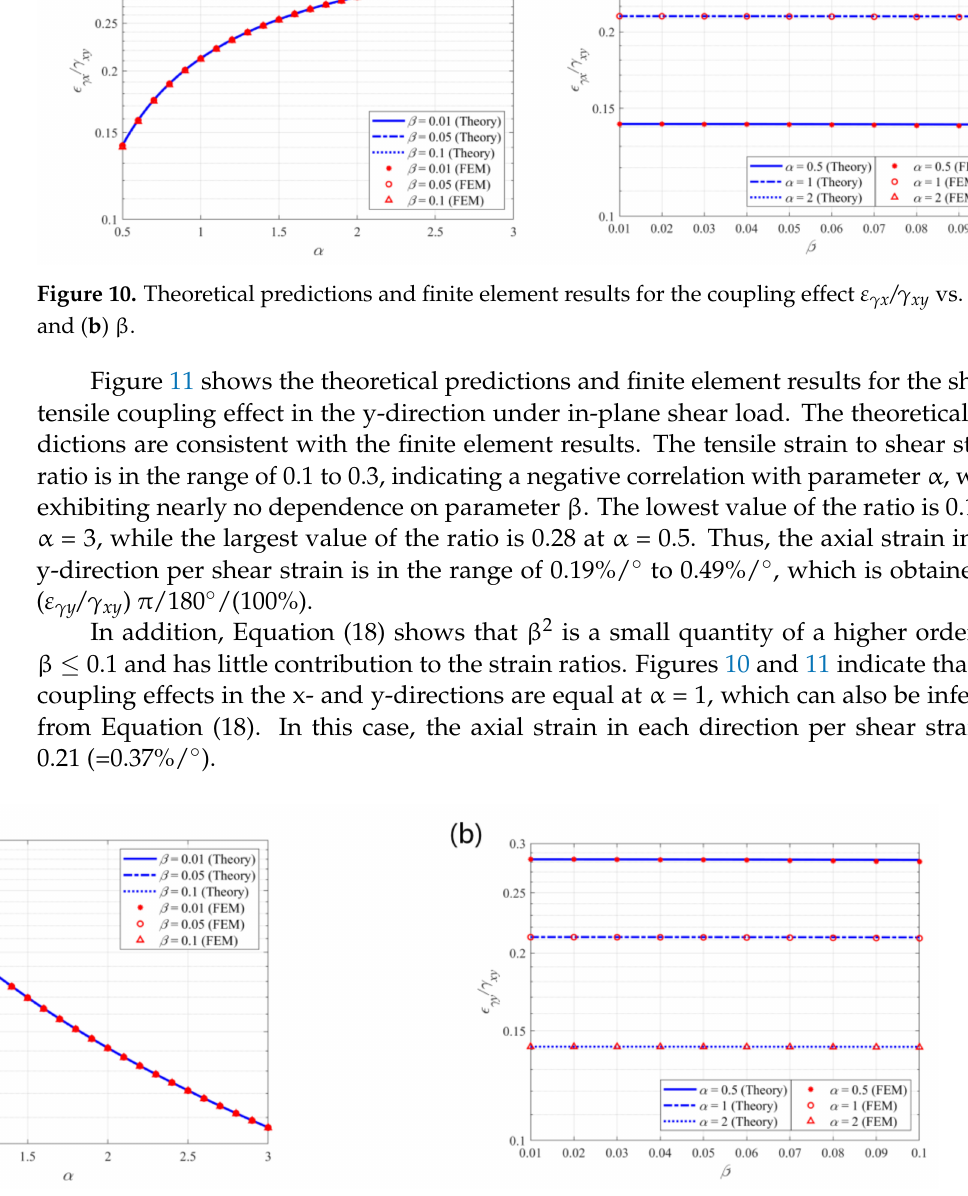
Figure 11. Theoretical predictions and finite element results for the coupling effect ε γ y / γ xy vs. ( a ) α and ( b ) β